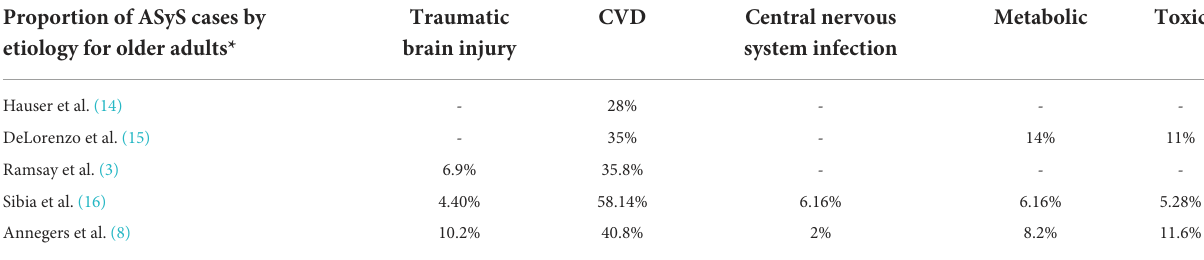
TABLE 1 Etiology of acute symptomatic seizures in older adults. Proportion of ASyS cases by etiology for older adults*